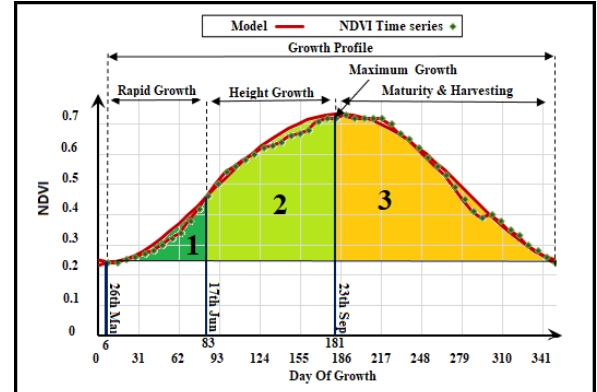
Figure 2. sugarcane growth profile based on NDVI To model the sugarcane yield, the values of cumulative vegetation index were related to observed sugarcane stem yields. Three methods with seven vegetation indices resulted in 21 different models that each model was examined separately.